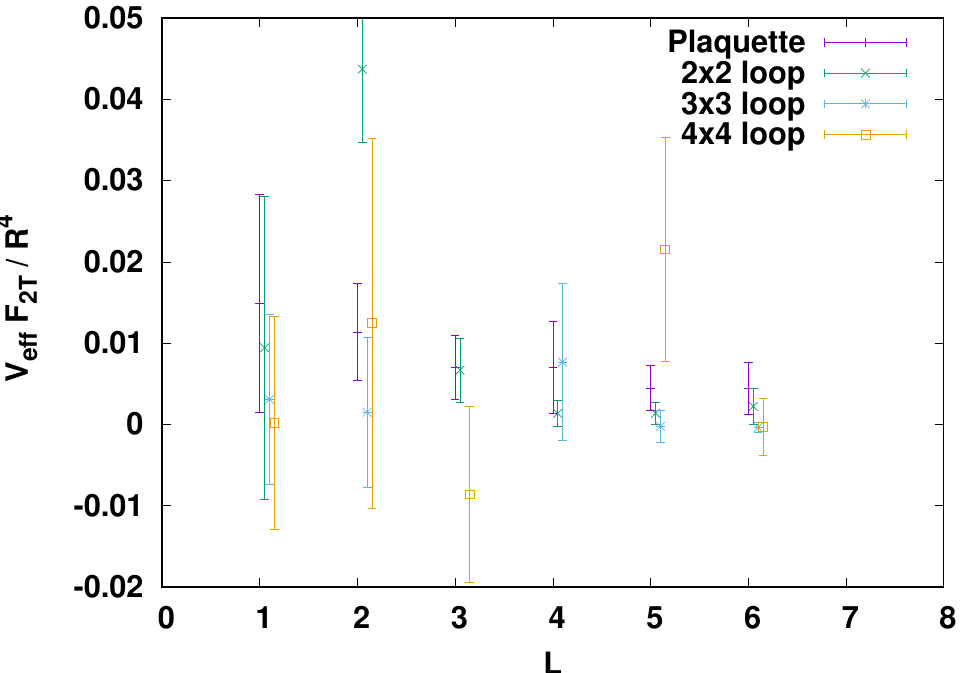
Figure 6. F 2 T for all square loops multiplied by the e(cid:11)ective volume and divided by the square of the area of the loop. The result is an average over various groups and sizes (see